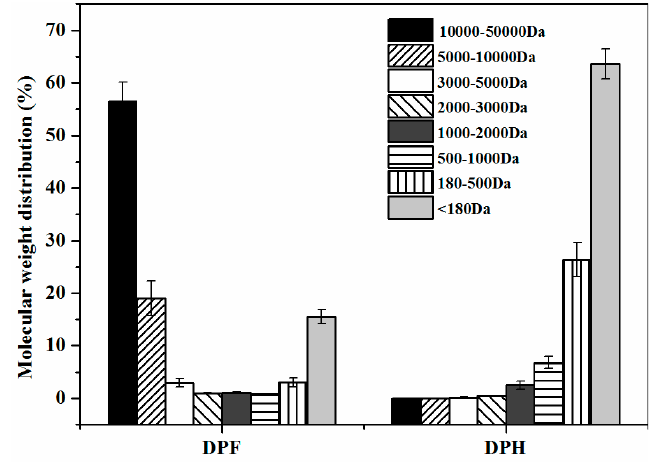
Figure 3. Molecular weight distribution of peptides.